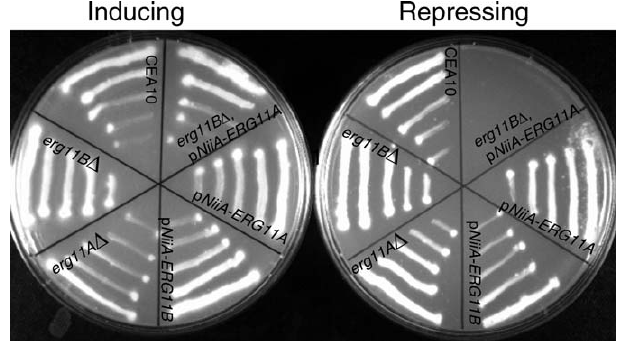
Figure 6. Phenotypic Analyses of ERG11 Gene Family Growth phenotypes of ERG11 gene family were observed with p NiiA -CPR mutants, null deletion mutants, and double mutants (erg11B D , p NiiA- ERG11A). Strains were grown on either inducing medium (AMM plus nitrate) or repressing medium (AMM plus ammonium) at 30 8 C for 40 h.